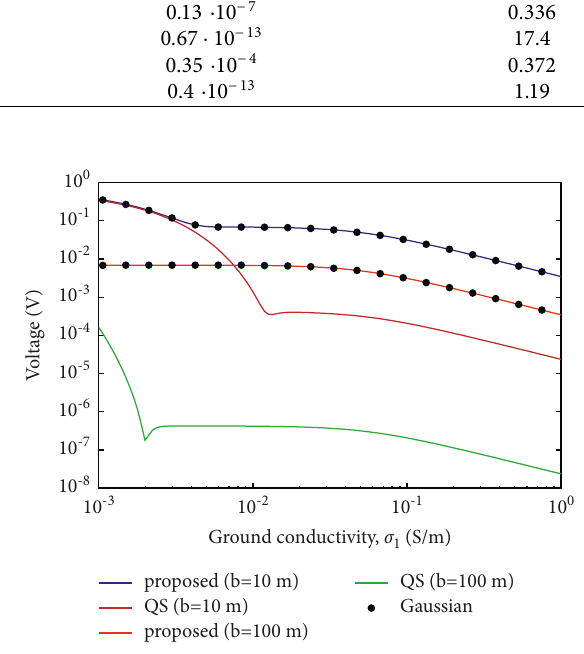
Figure 5: Voltage induced in the small loop as a function of the ground